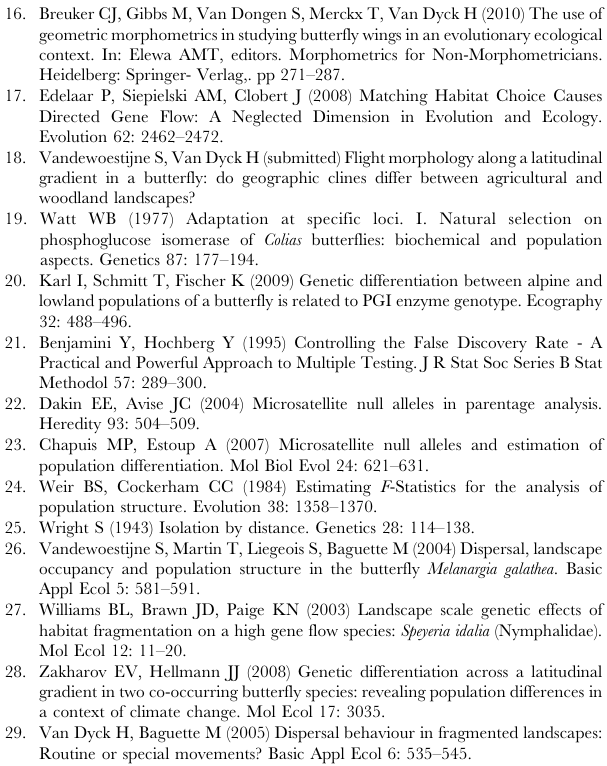
(frequency . 5%, present in less than 25% populations). Table S3 Variation in genetic diversity (based on microsatellites) in relation to latitude, landscape and latitude x landscape. He : unbiased expected heterozygosity, A: allelic richness, Private A: private alleles, LCA25: locally common alleles (allele frequency . 5%, present in less than 25% populations). Bold values: p , 0.05, italic values: p , 0.10. Table S4 Regression of allozyme diversity against latitude, landscape and latitude x landscape. (A) all enzymes and (B) all enzymes without PGM. Table S5 Likelihood ratio test (LRT) between several maximum likelihood based dispersal models. Full model (dispersal rate were free to vary between all populations), woodland source model (dispersal from agricultural into woodland populations was estimated as zero), landscape-selective dispersal model (dispersal was symmet- ric between populations within the same landscape and free to vary between different landscapes). AIC values for each model are shown. Model with the lowest AIC is the most likely model. For latitudinal zone correspondence, consult code in Table S2. Table S6 Allele frequency data for allozyme and microsatellite markers used in this study. Please refer to Figure 1 and Table S2 for population code. Figure S1 Allozyme based observed heterozygosity in relation to latitude and landscape. Full line: linear regression for agricultural